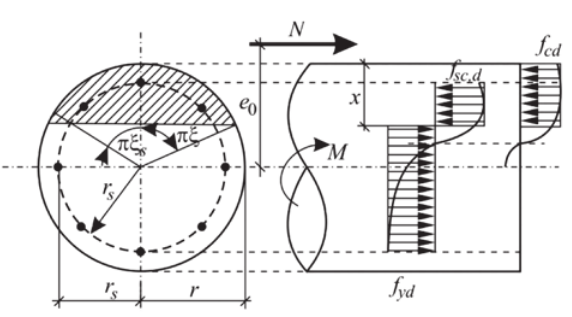
Fig. 3. Modelling of stresses in the steel reinforcement and concrete of eccentrically loaded circular cross-section elements